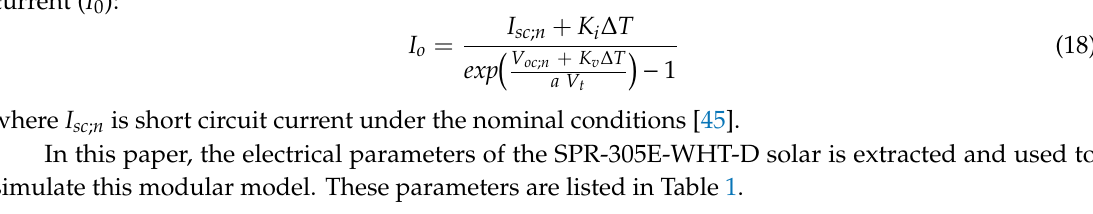
Table 1. Electrical parameters of the SPR—305 E—WHT—D photovoltaic.